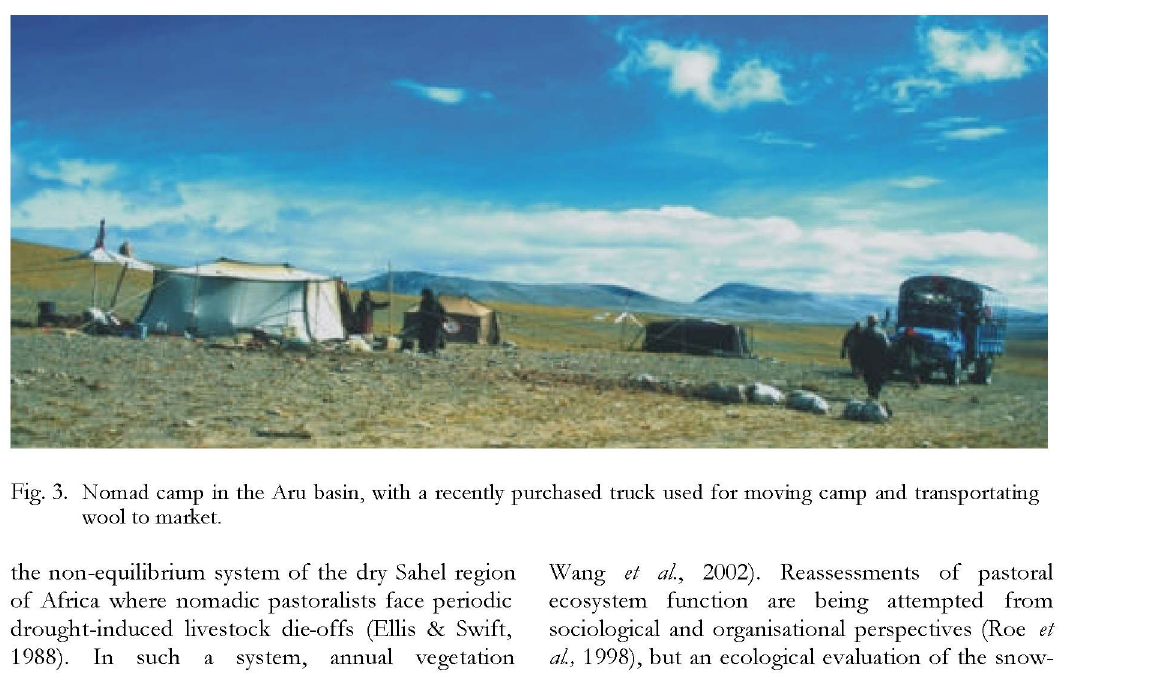
Fig. 3. Nomad camp in the Aru basin, with a recently purchased truck used for moving camp and transportating wool to market. the non-equilibrium system of the dry Sahel region of Africa where nomadic pastoralists face periodic drought-induced livestock die-offs (Ellis & Swift,